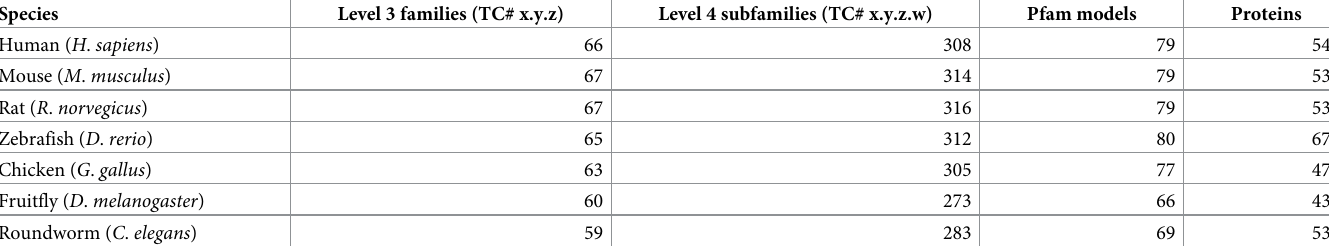
Table 2. Results of the initial search for “SLC-like” proteins. The search was performed using HMM-based sequence similarity analysis based on selected families and subfamilies from the TCDB, as well as selected Pfam models that likely encode transmembrane domains of “SLC-like” transporters (see text for details). The table shows the number of families, subfamilies from the TCDB and the number of Pfam models that had representative sequences in each organism. In addition, the initial number of “SLC-like” proteins found is shown. Species Level 3 families (TC# x.y.z)